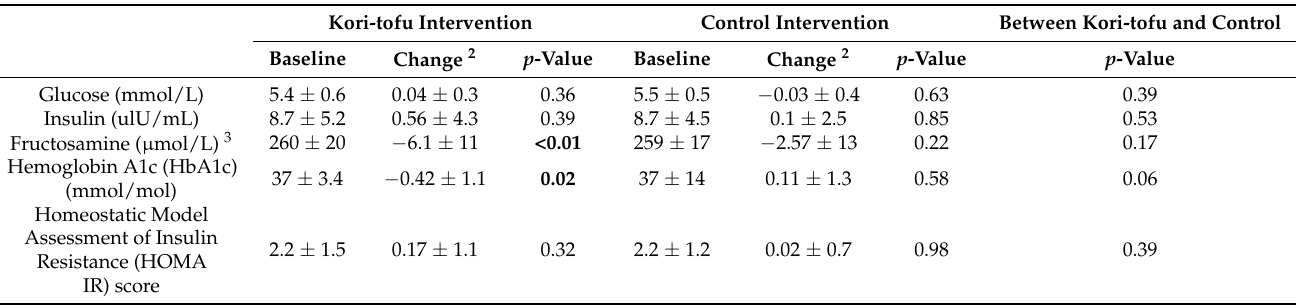
Table 3. Glucose metabolism markers at baseline and change after 4 weeks Kori-tofu or control intervention 1 .